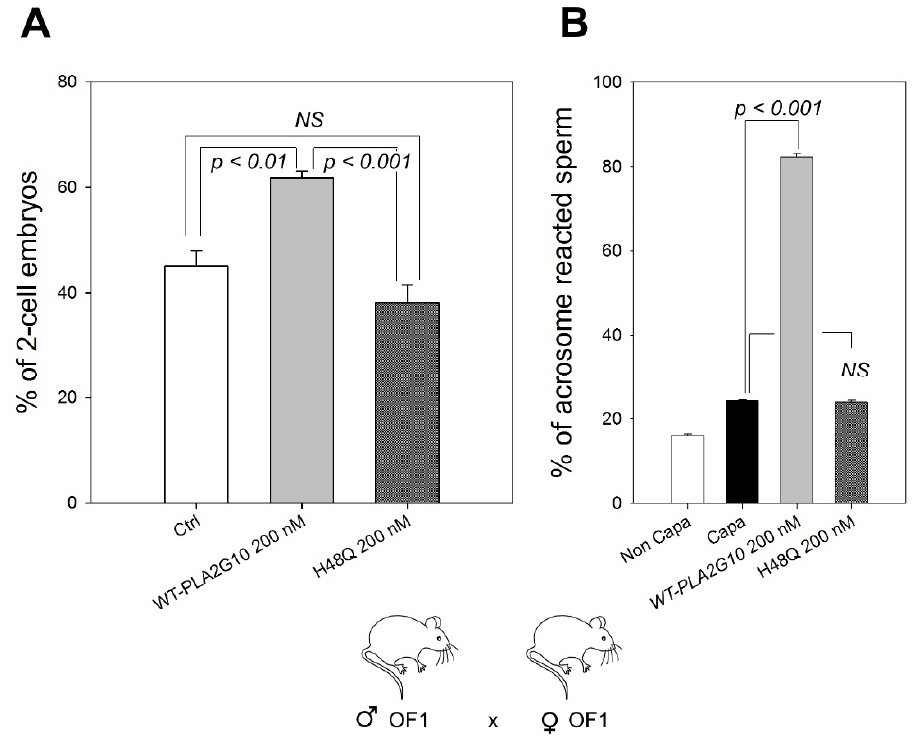
Figure 4. The H48Q-PLA2G10 mutant is unable to improve fertilization in the OF1 strain. ( A ) Percentages of two-cell embryos obtained with sperm and oocytes from OF1 animals. OF1 sperm were capacitated for a total duration of 55 min in M16-2% BSA and incubated at the end of the capacitation period with water (control, n = 6), WT-PLA2G10 ( n = 6) or its catalytically-inactive mutant H48Q-PLA2G10 ( n = 6). After treatment, washed sperm were introduced in droplets containing OF1 oocytes, and IVF outcomes were scored 24 h later. Statistical comparisons were made with a paired t -test. ( B ) Sperm were capacitated for 45 min in M16 medium containing 2% BSA, and capacitated sperm were treated for 10 min with either 200 nM of WT-PLA2G10 or H48Q-PLA2G10 and acrosome-reacted sperm were scored ( n = 6). n represents the number of biological replicates, and for each replicate, more than 100 sperm cells were assessed per condition. The statistical difference in the mean was assessed using the t -test. p -value, as indicated. NS, not significantly different. To better analyze the difference between the two strains, we performed inter-strain IVF between OF1 and C57BL/6 gametes. We first mixed sperm from OF1 males, treated or not with H48Q-PLA2G10, with MII oocytes from either C57BL/6 or OF1 females. Figure 5 shows that switching the origin of oocytes from OF1 to C57BL/6 is sufficient to restore the boosting effect of H48Q-PLA2G10 on fertilization outcome (Figure 5A,B). Figure 5C compares the percentage of IVF increase (calculated as “(rate of fertilization with sPLA 2 - treated sperm × 100/rate of fertilization with control sperm)” × 100) obtained in both experimental conditions with H48Q-PLA2G10 and clearly shows the restoration of the positive effect of treatment of sperm by H48Q-PLA2G10 when oocytes were obtained from C57BL/6 females. This result demonstrates that the IVF effect of H48Q-PLA2G10 is at least partially mediated by the C57BL/6 female